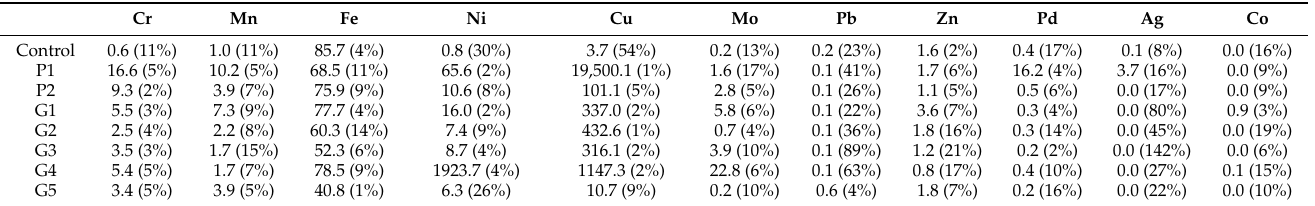
Table 1. Concentration of metal ions (Parts per billion, ppb) in each conditioned medium and control medium. Relative standard deviation percentages are indicated in brackets ( n = 3).